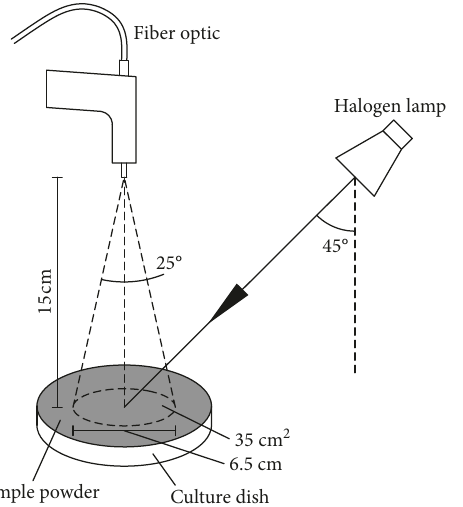
Figure 2: Reflectance spectra acquisition of powder sample in 0.5mm grain size using a field spectrometer and a halogen lamp light source.